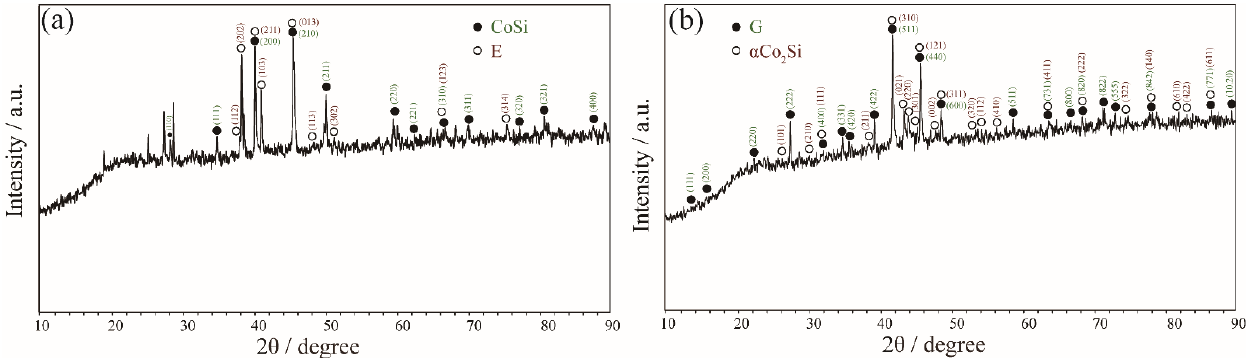
Figure 7. XRD patterns obtained of ( a ) Co 46 Ta 13 Si 41 alloy annealed at 1100 °C for 60 days and ( b ) Co 58 Ta 10 Si 32 alloy annealed at 1100 °C for 60 days.